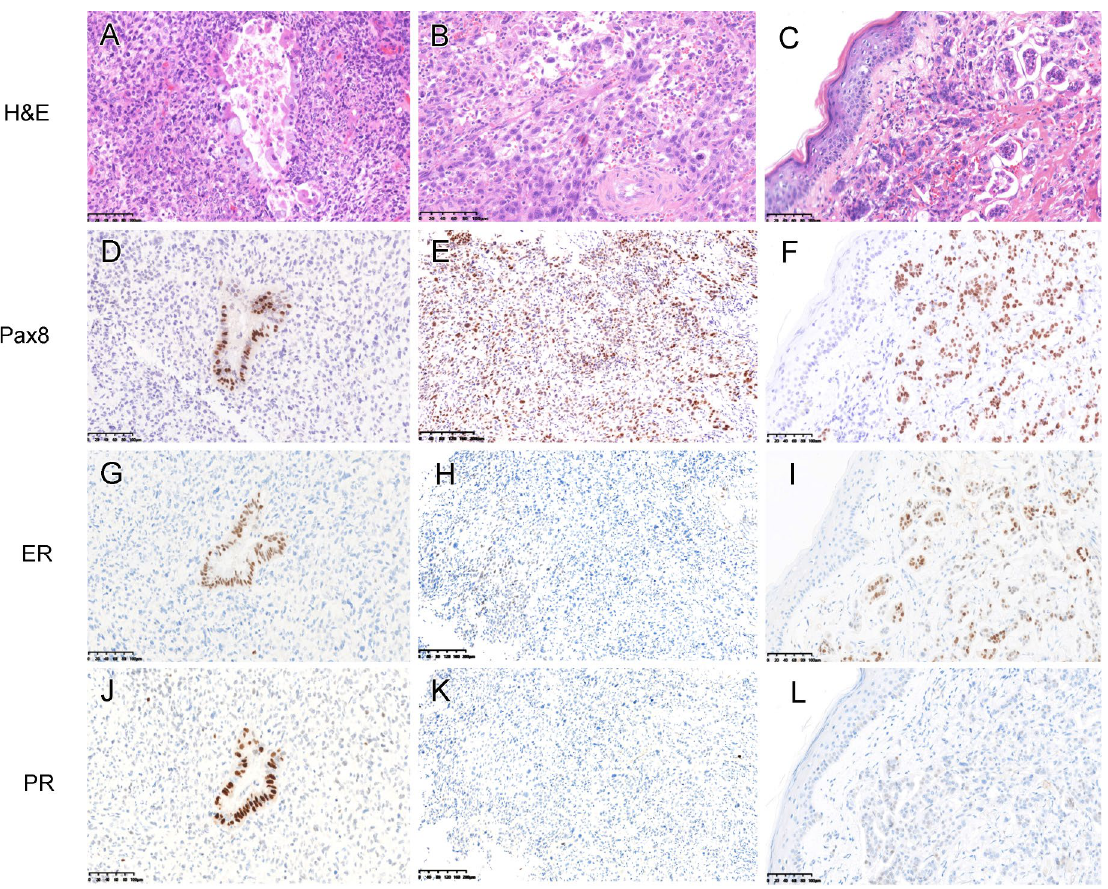
Fig. 3 The carcinomatous component of ovarian carcinosarcoma (A and B, corresponding to Fig.1C and 1D) and skin metastatic adenocarcinoma (C, cor- responding to Fig.1I) were positive for Pax8 (D-F). ER was diffusely positive in the seromucinous/endometrioid carcinoma (G) and metastatic carcinoma (I) but showed only weak and focal positivity in the high-grade serous carcinoma (H). PR was also diffusely positive in the seromucinous/endometrioid carcinoma (J) but negative in other component (K,